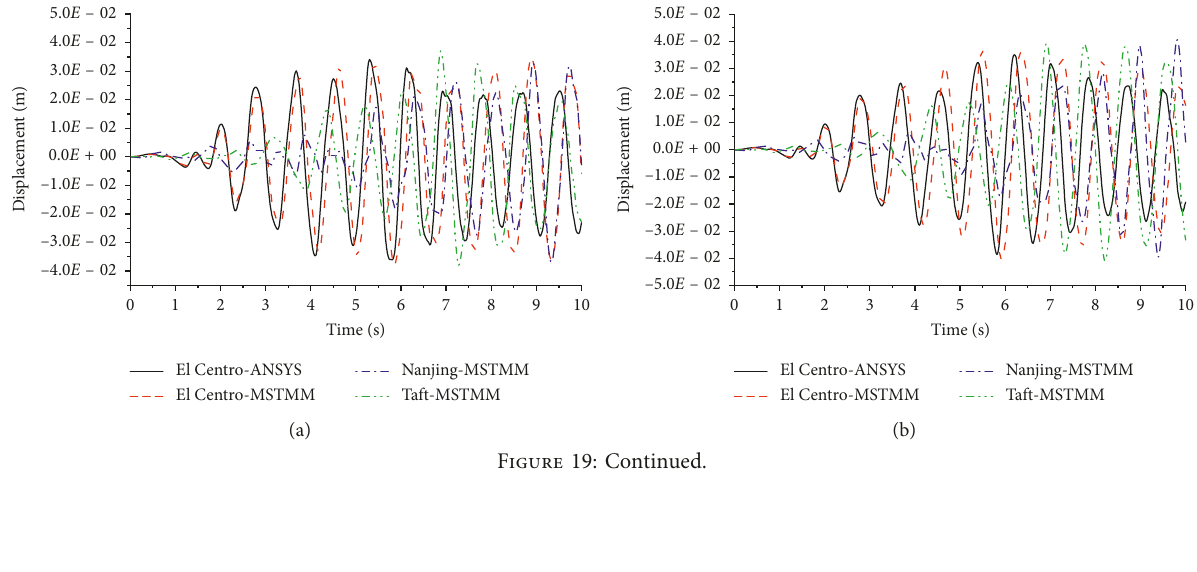
Figure 18: Time-history diagram of J (c) 210mm.